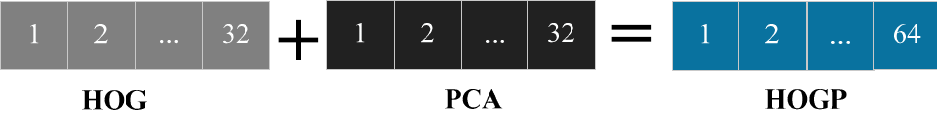
Figure 4. The framework for building a HOGP feature.